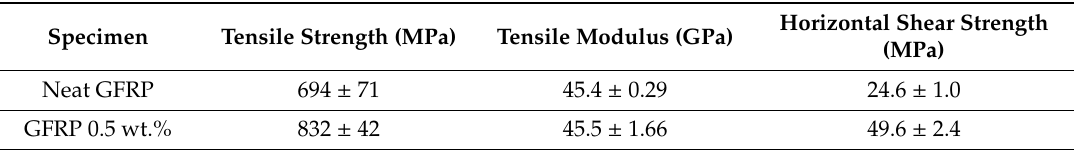
Table 3. Elastic modulus, tensile strength, and horizontal shear strength of pultruded neat GFRP